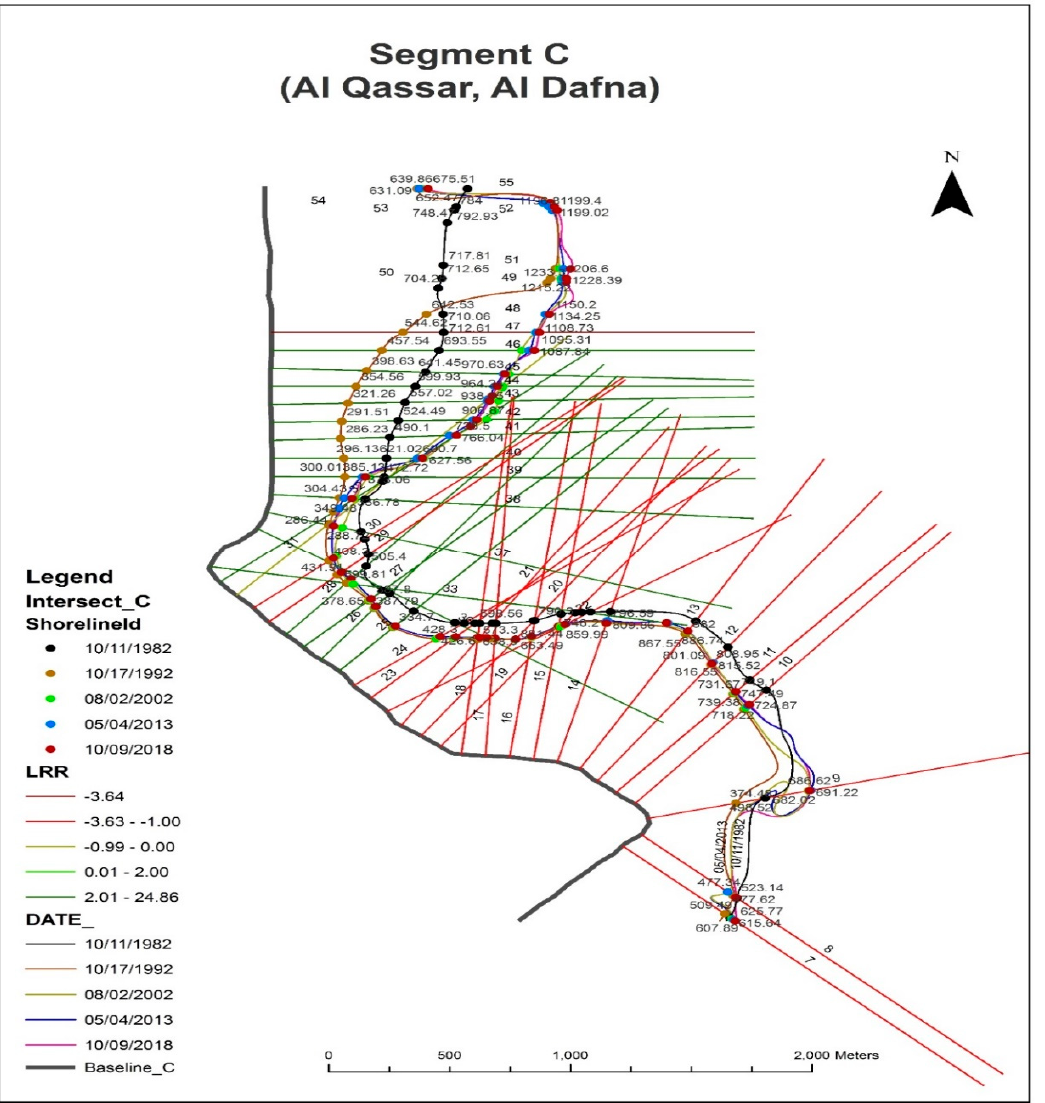
Figure 13. Shoreline of Al Qassar and Al Dafna area. Segment C underwent over 200 m of shoreline erosion or submergence from 1982 to 1992. However, it recovered 480 to 600 m of land towards the sea over the next decade. The shoreline has been stable since 2002, with changes ranging from ± 1 m to 50 m. Analysis of the shoreline distance data reveals that the green-coloured transects had similar shoreline changes to those of transects 41 and 42. Transects 10 and 11 also witnessed a significant shoreline loss from 1982 to 1992, with a high erosion rate of − 12.24 m/y. Since 1992, there has been a low accretion rate of 0.67 m/y to 1.29 m/y. From 1992 to 2018, land recovery was less than 50 m, while the land erosion from 1982 to 1992 exceeded 100 m. The red-coloured transects exhibited similar shoreline change patterns to those of transects 10 and 11. Unlike Lusail City and The Pearl, Al Dafna’s shoreline has declined by roughly 800 m over the past 36 years. There was 300 m of shoreline accretion from 1982 to 2002, followed by 1600 m of shoreline erosion over the next 16 years. Despite the overall land reduction, the rate of change is relatively low, making Al Dafna’s shoreline moderately stable when viewed on a larger